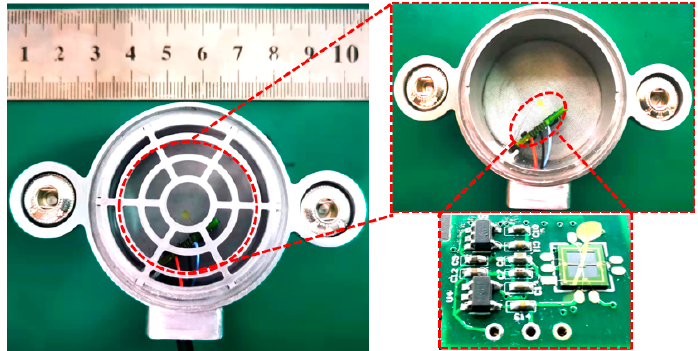
Figure 9. Overall packaging of MEMS cardiac sound sensor.